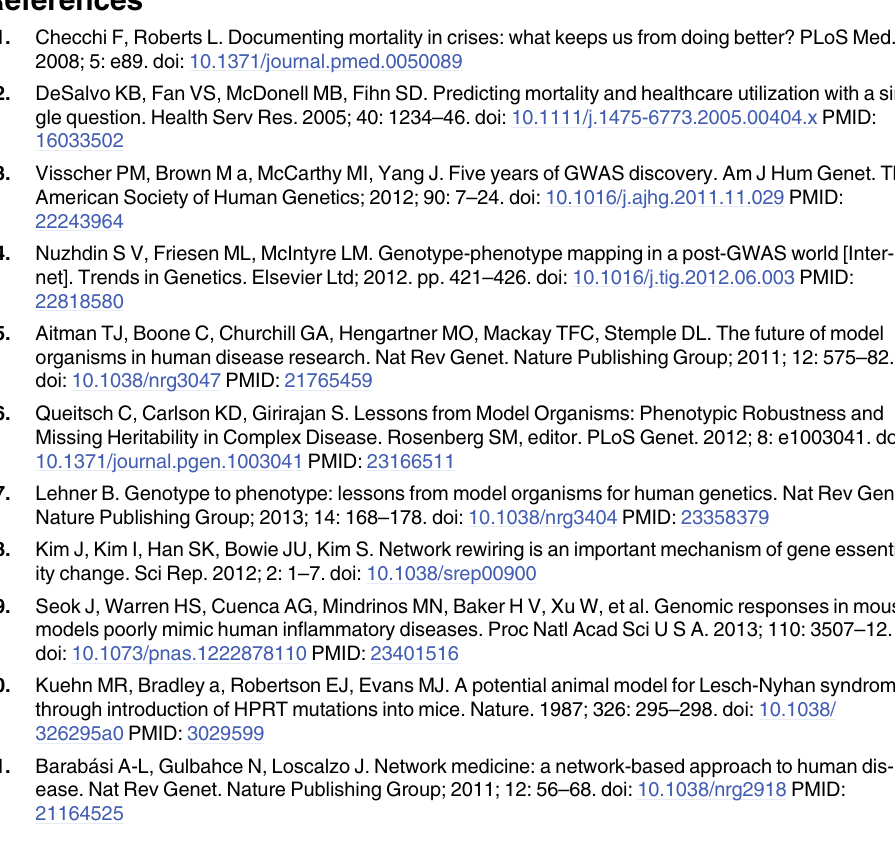
S1 Table. The list of essential and nonessential disease genes. S2 Table. The list of essential/nonessential links and shared genes in HDN. S3 Table. The case fatality rate of human diseases enriched with essential and nonessential genes. S4 Table. The list of protein interactions from integration of 22 protein interaction data-